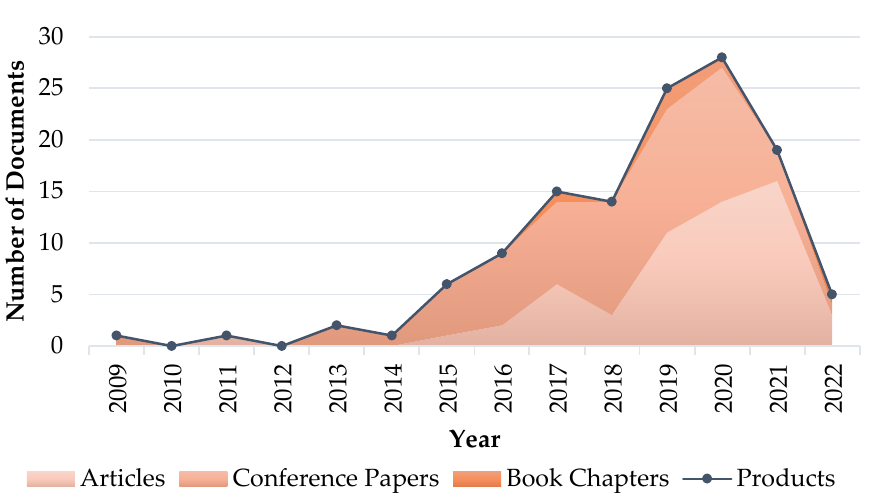
Figure 8. Number of published documents by year, collected by publication type. Classes are reported as a stack plot, and the total amount of products by year is reported in black line with